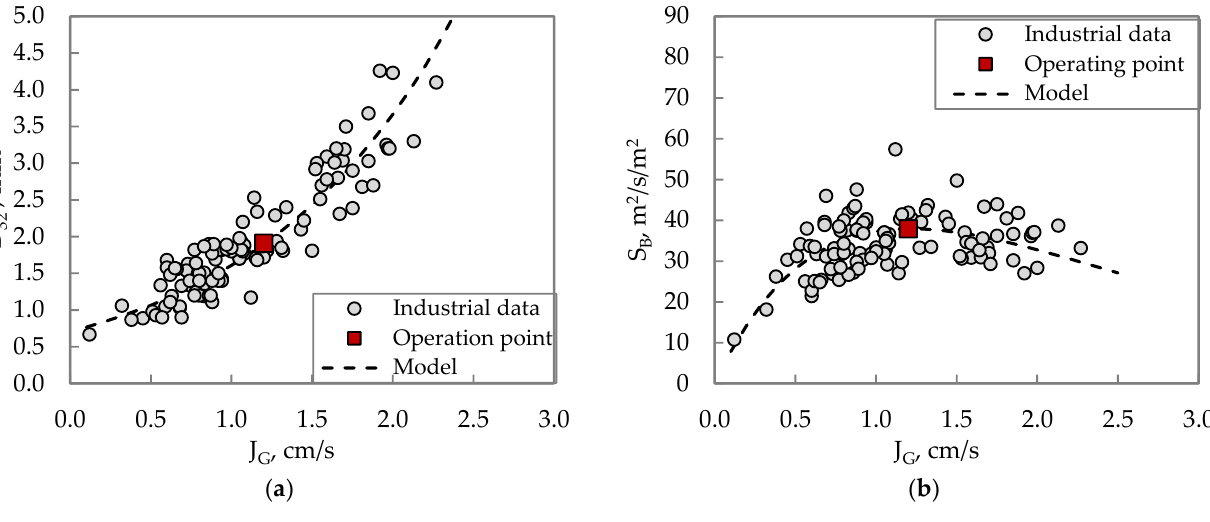
Figure 5. Relationships of J G with ( a ) D 32 and ( b ) S B .